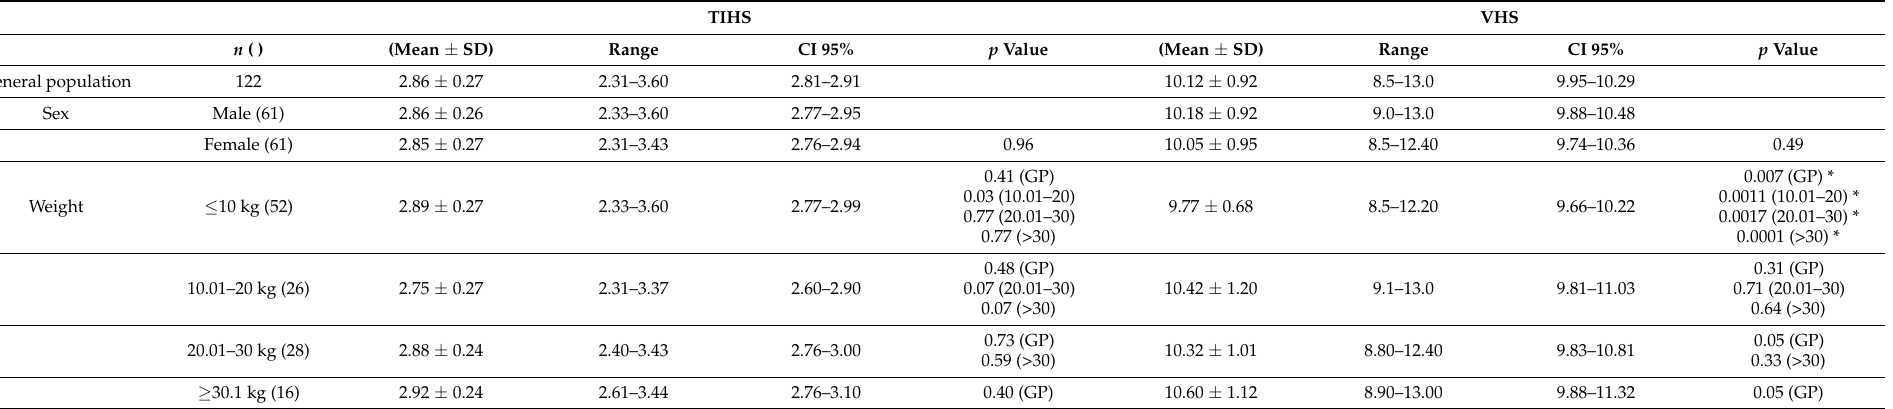
Table 1. Mean (SD), range, and 95% Confidence Interval (CI) for measurements of the cardiac size on a right lateral thoracic radiographic projection obtained from 122 normal dogs. p < 0.01. n number of dogs. TIHS Thoracic Inlet Heart Size. VHS Vertebral Heart Size. * Difference statistically significant in VHS value between ≤ 10 kg group the general population, and the other groups.